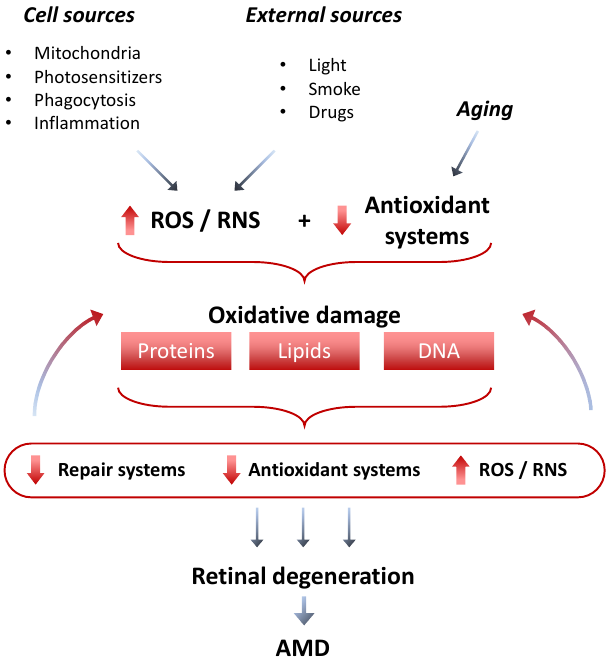
Figure 2. Mechanisms at the basis of oxidative damage in AMD. ROS: reactive oxygen species; RNS: reactive nitrogen species; AMD: age-related macular degeneration.